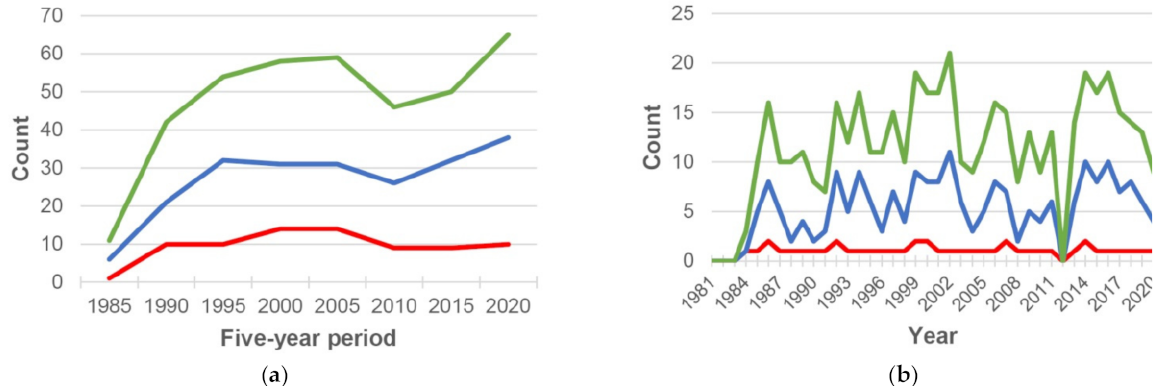
Figure 4. Minimum (red), median (blue) and maximum (green) clear measurements per pixel count for generated Landsat mosaics over study area: ( a ) five-year composites; ( b ) annual